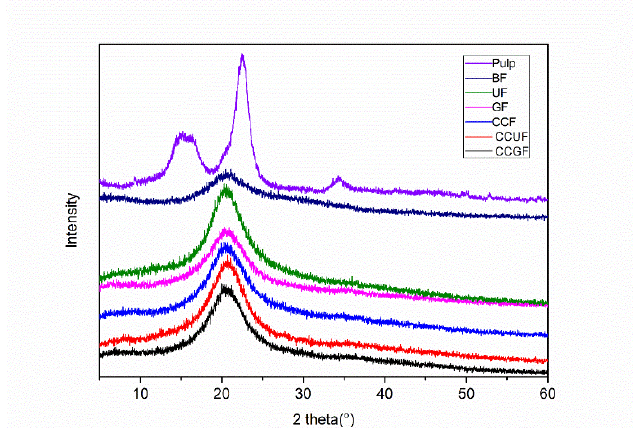
Figure 3. X-ray diffraction patterns of pulp and regenerated cellulose fibers with or without addi-